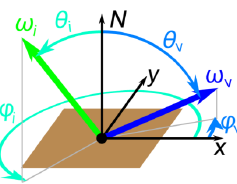
Fig. 1 Parameterization of the